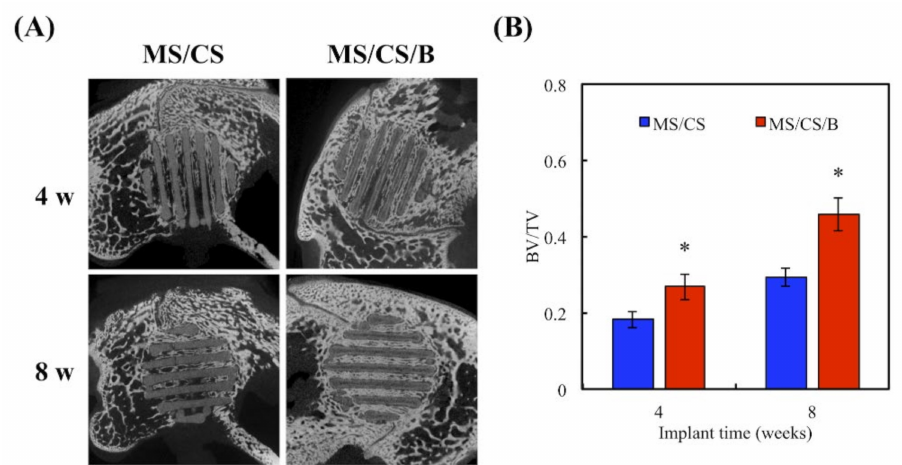
Figure 11. ( A ) Micro-CT image showing the morphology of bone growth for a fixed-sized critical lesion after it underwent 8-week regeneration with scaffolds; ( B ) data analysis of relative bone mass volume (bone volume/tissue volume (BV/TV) ratio) for a fixed-sized critical lesion after it underwent 8 weeks of regeneration with scaffolds. * indicates a significant difference ( p < 0.05) when compared to MS/CS.